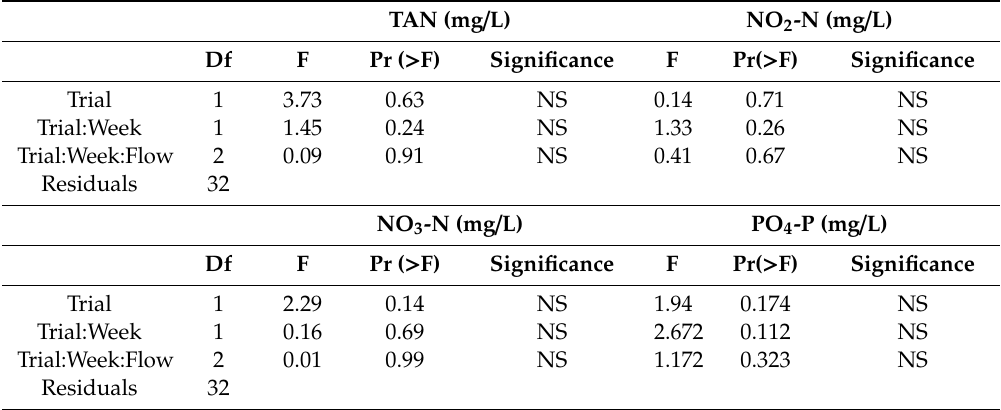
Table 4. Statistical analysis (ANOVA) of nutrients in the System 4 growbeds (Trial 1 and Trial 2), which were subjected to di ff erent flow rates (500, 160, and 40 L / h).